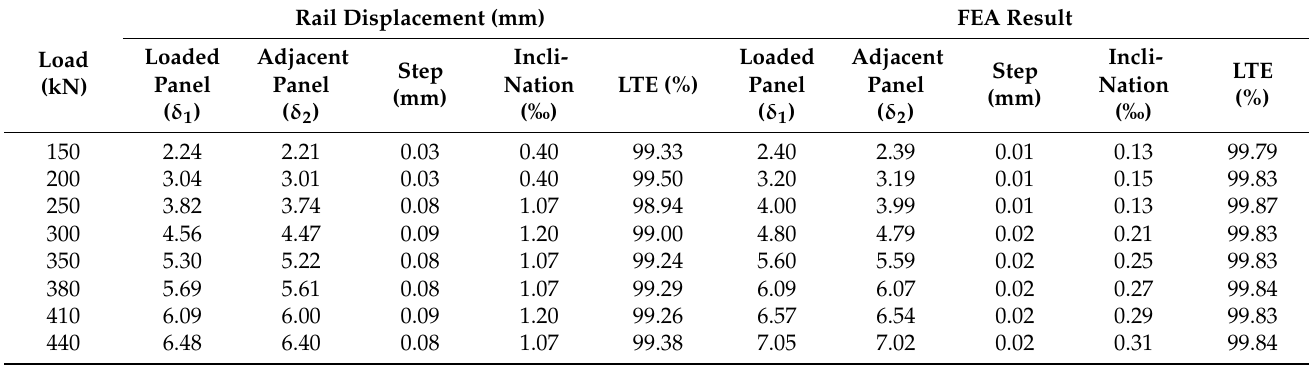
Table 6. Load transfer efficiency (LTE) of rail between panel endpoint and panel adjacent (Load at 2nd panel 4/4 loading point).